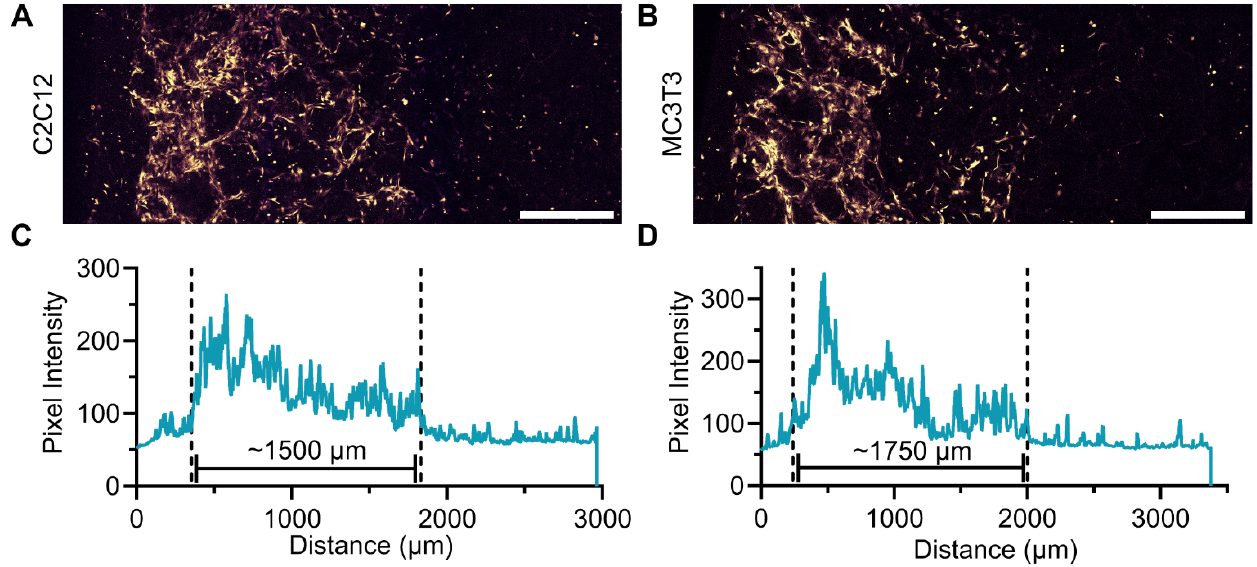
Figure 3. Cell penetration into the 3D collagen scaffolds. Collagen scaffolds were seeded with 1.5 × 10 6 cells and after 24 h stained with CellTrace Yellow, fixed, and cleared. ( A ) Stitched image of 3 neighboring Z-stacks of C2C12 cells, cutting direction is equal to cell seeding direction. ( B ) Stitched image of 3 neighboring Z-stacks of MC3T3 cells, cutting direction is opposite to cell seeding direction. ( C , D ) Cy5 intensity profiles measured in Z-projections of ( A ) C2C12 cells and ( B ) MC3T3 cells, a pixel intensity threshold of 100 was used to quantify depth of cell penetration throughout the collagen scaffold. Brightness and contrast were equally adjusted across conditions. Scale bars represent 500 µm.